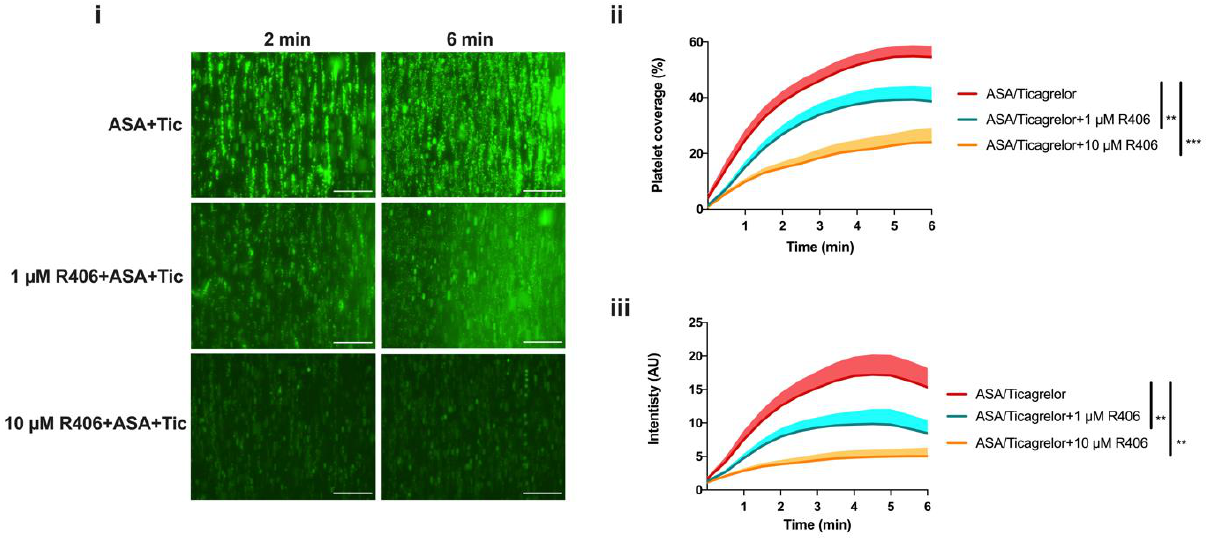
Figure 6. R406 provided additive inhibition of platelet thrombus formation over collagen when added to blood of patients taking aspirin and ticagrelor dual antiplatelet therapy. Whole blood from patients taking aspirin and ticagrelor was incubated with R406 or vehicle (0.1% DMSO) for 10 min at 37 °C, then perfused over a 200 µg/mL Horm collagen-coated chamber at a shear rate of 1000 s − 1 . Platelets were labelled with 2 µM of DiOC 6 for 10 min prior to perfusion for visualisation. ( i ) Representative images display platelet aggregate formation at 2 and 6 min after start of perfusion. Scale